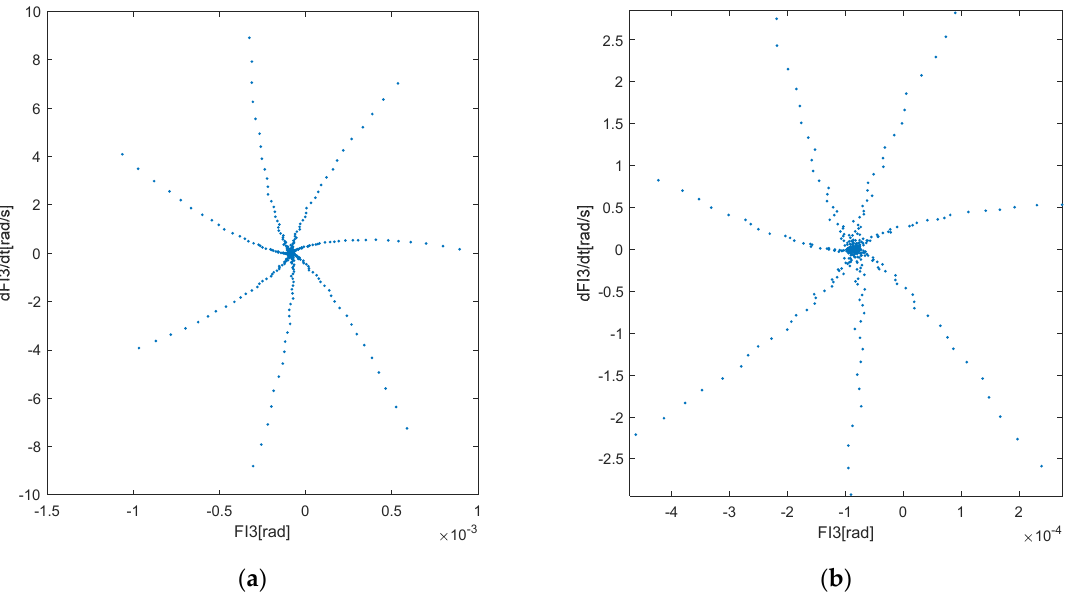
Figure 28. Poincaré Map of DOE3 for Figure 28. Poincar é Map of DOE3 for β 2 = 9 0 , ξ = 1.6 · 10 − 3 , η 3 = 2792Hz ( a ) N = 50,000 ( b ) N =